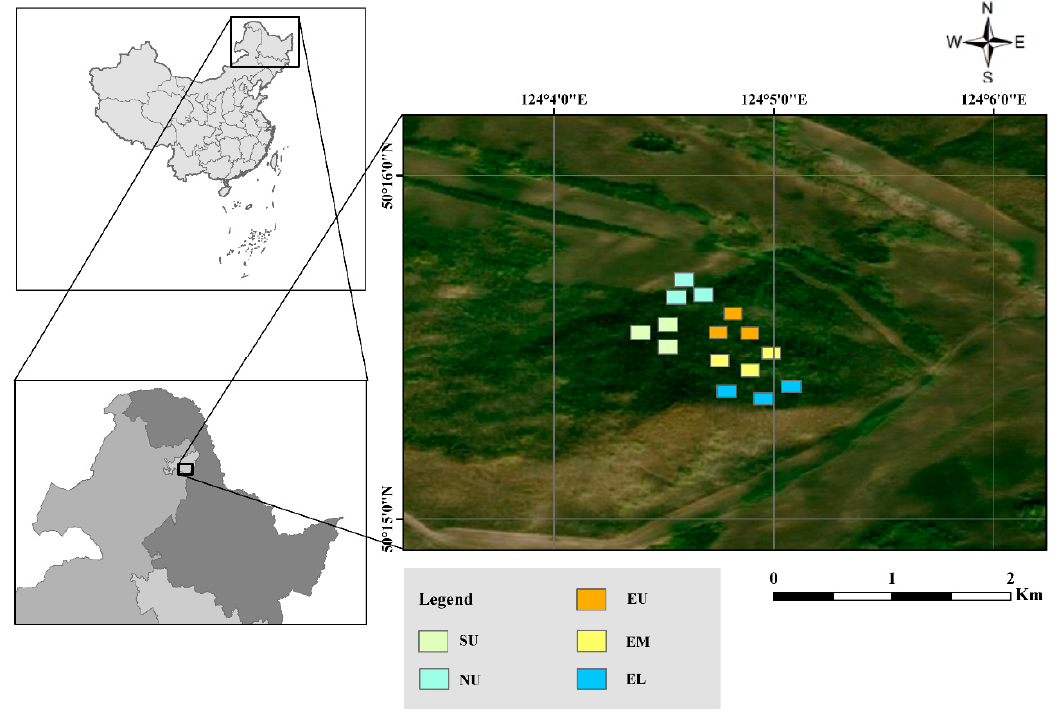
Figure 1. Location and basic information of the study area and sampling sites. The abbreviations of sampling sites are as follows: SU, the upper slope of the south; NU, the upper slope of the north; EU, the upper slope of the east; EM, the middle slope of the east; EL, lower slope of the east.